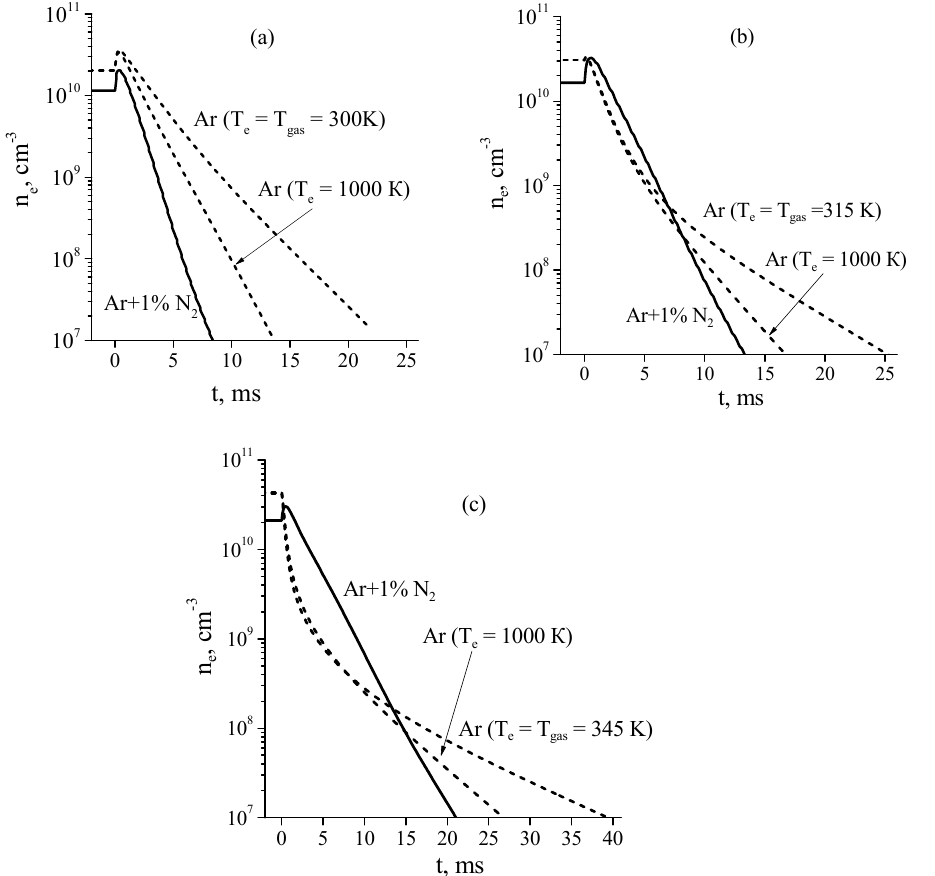
Figure 7. Calculated electron densities in the discharge ( t ≤ 0) and in the afterglow ( t > 0) at a discharge current of I = 20 mA and gas pressures of Р = 1 ( a ), 2 ( b ), and 5 Torr ( c ), respectively [26].